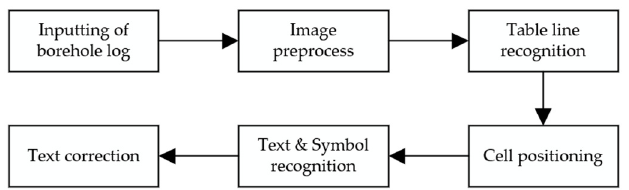
Figure 4. Automatic extraction flow of borehole log information.